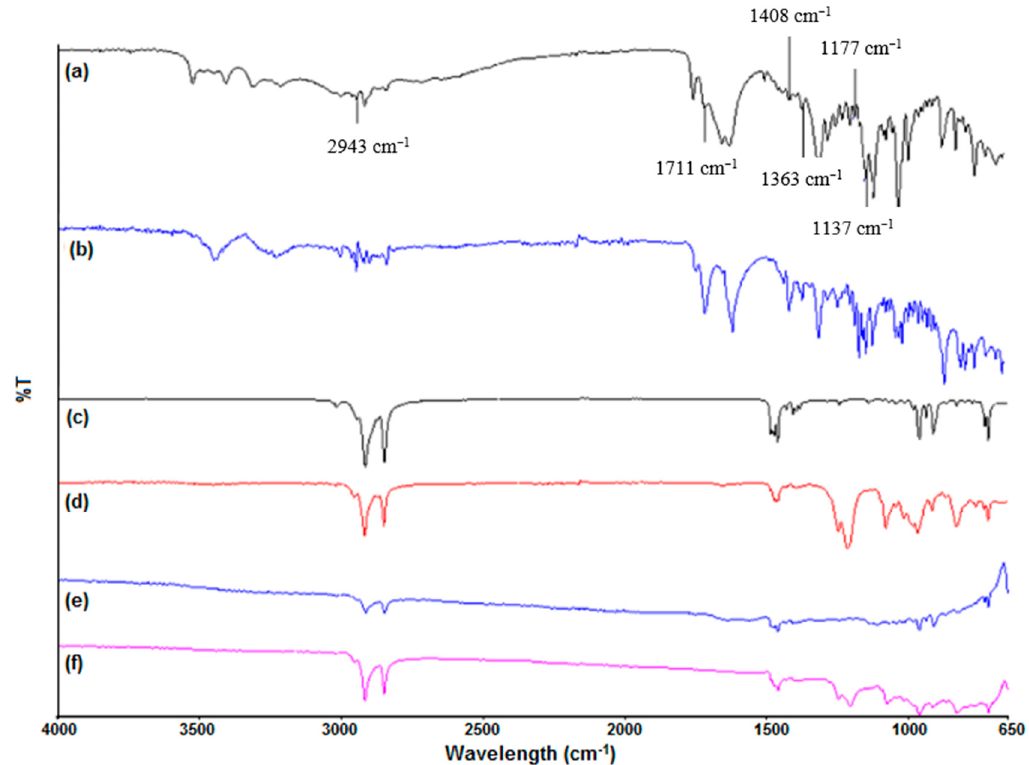
Figure 3. Fourier-Transform Infrared (FTIR) spectra of: ( a ) ascorbic acid; ( b ) Sample S1; ( c ) CTAB; ( d ) SDS; ( e ) Sample S4; and ( f ) Sample S5.